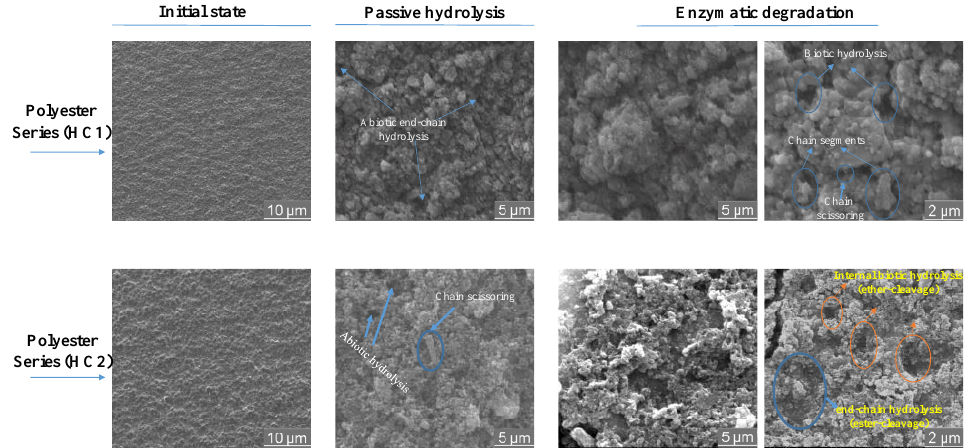
Figure 13. Enzymatic degradation and visual observation of degraded films after 90 days of incubation at a constant pH of 7.4.